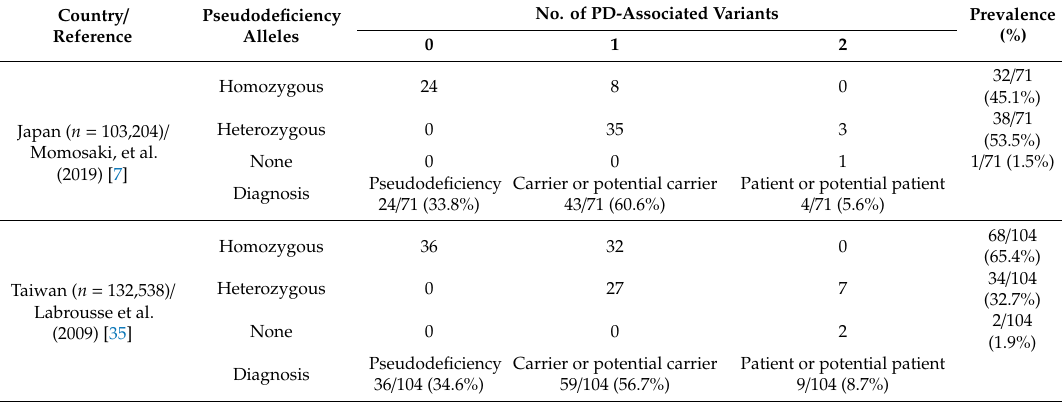
Table 2. The distribution of pseudodeficiency alleles and PD-associated variants in newborns who were detected by NBS for